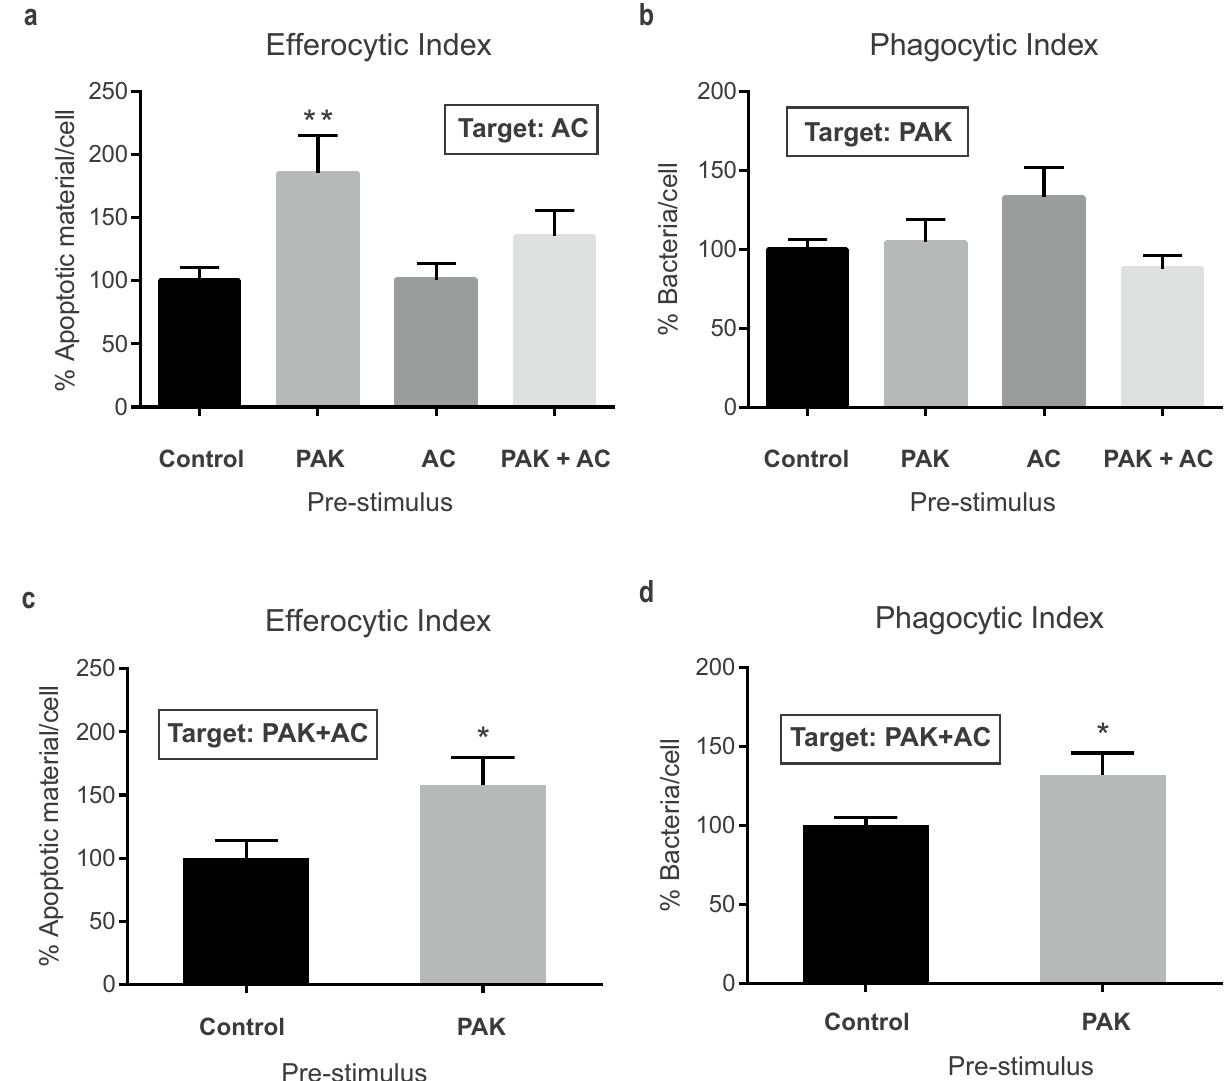
Figure 3. BMDM Efferocytic Index is increased by P. aeruginosa pre-stimulation . ( a ) BMDM Efferocytic Indexes after different stimuli are shown. BMDM were incubated for 50 min with different pre-stimuli: PAK (bacteria), AC (apoptotic cells), PAK + AC (PAK with AC concurrently) and Control (non-stimulus). The efferocytic capacities using apoptotic cells as targets were checked 18 h after pre-stimuli. The